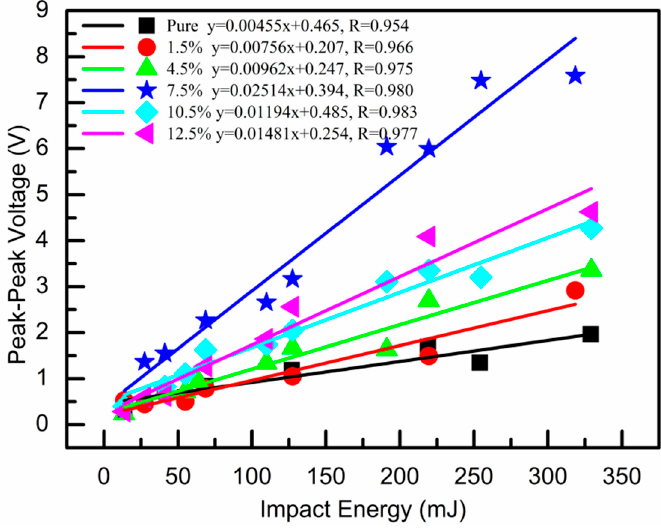
Figure 12. Peak-to-peak voltage versus impact energy curves of PVDF-TrFE/nano-ZnO films with different nano-ZnO contents.